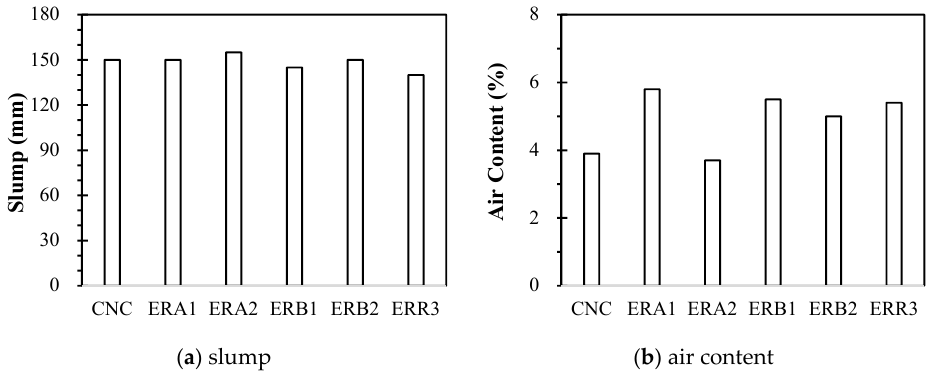
Figure 4. Test values of slump and air content by different mix design methods.